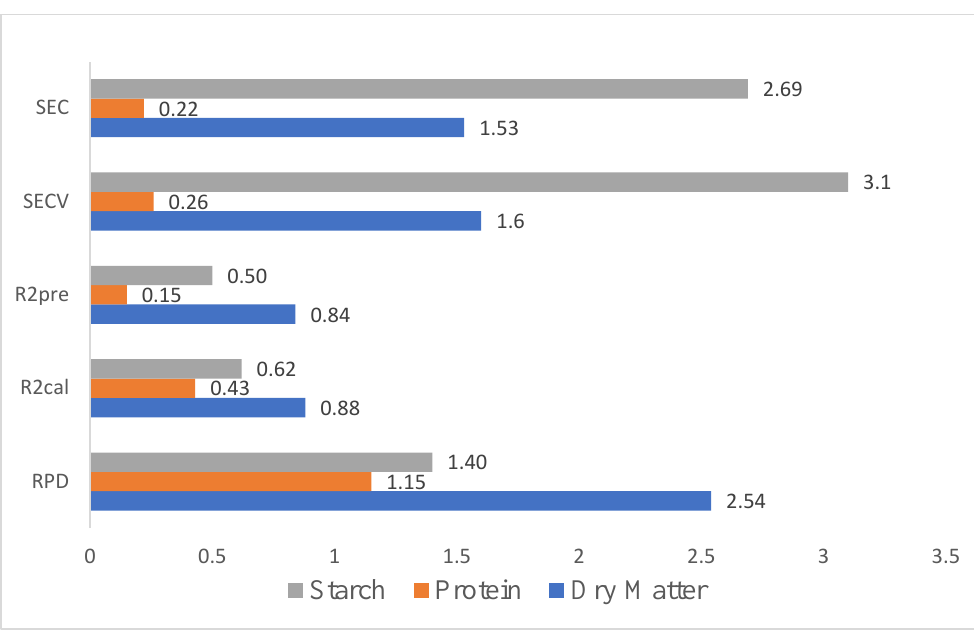
Figure 3. NIRS calibration and validation statistics for blended fresh yam tubers. SEC : standard error of calibration; RPD : the ratio of performance to deviation; SECV : standard error in cross-validation; R 2Cal : the determination coefficient for calibration; R 2pre : the determination coefficient for prediction.